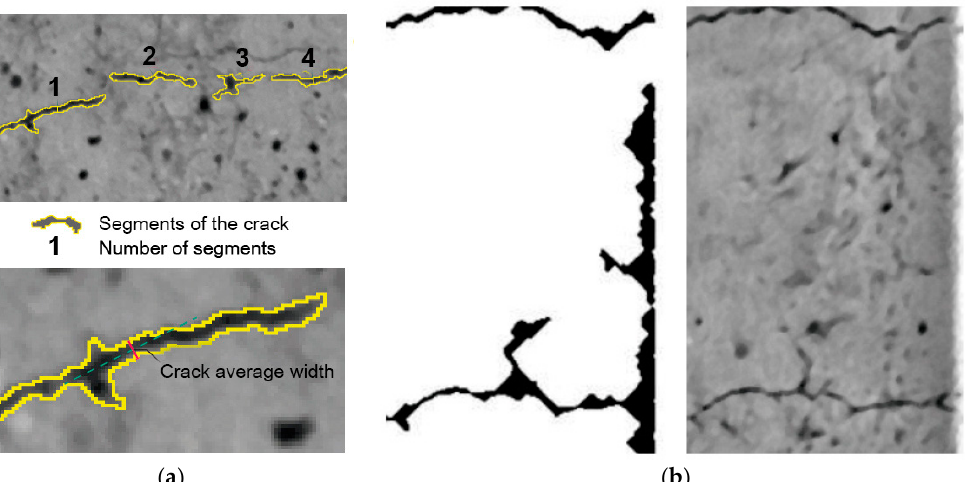
Figure 9. Measurement and detection of cracks: ( a ) measurement of crack opening width as a mean value; and ( b ) “boundary effect” in segment detection.